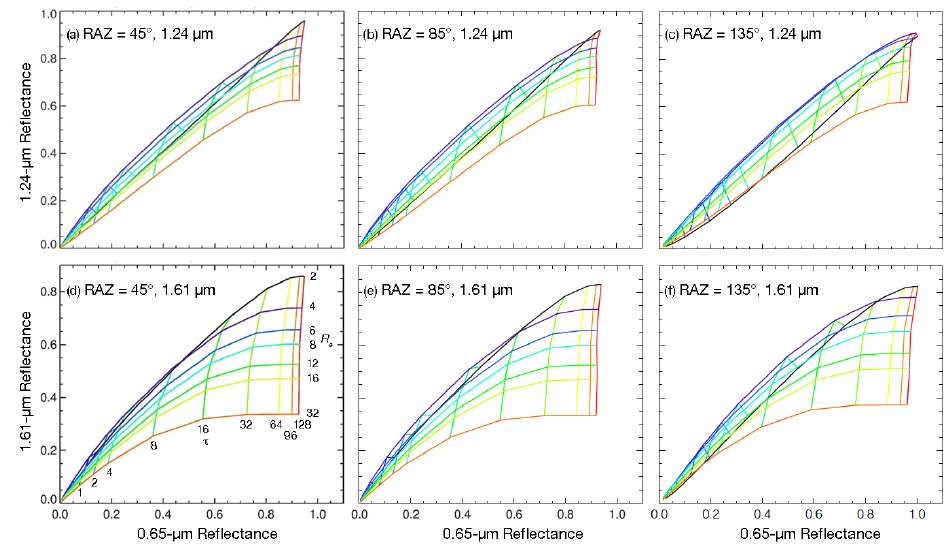
Figure 19. Model liquid water cloud NIR reflectance versus VIS reflectance from CV1S LUTs at SZA = 45.6°, VZA = 31.8° for range of COD , and CERw , denoted as τ and R e , respectively. ( a – c ) 1.24-µm and ( d – f ) 1.61-µm reflectances for RAZ = 45° (left column), RAZ = 85° (center column), and RAZ = 135° (right column).